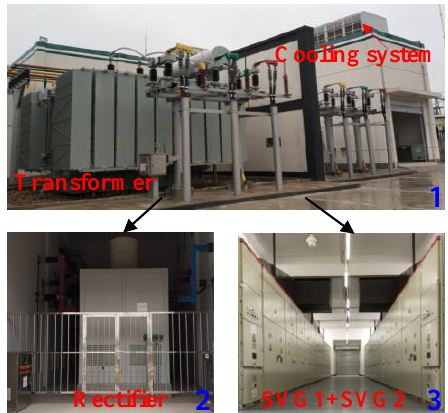
Figure 12. Compensation 35 kV system reactive power.